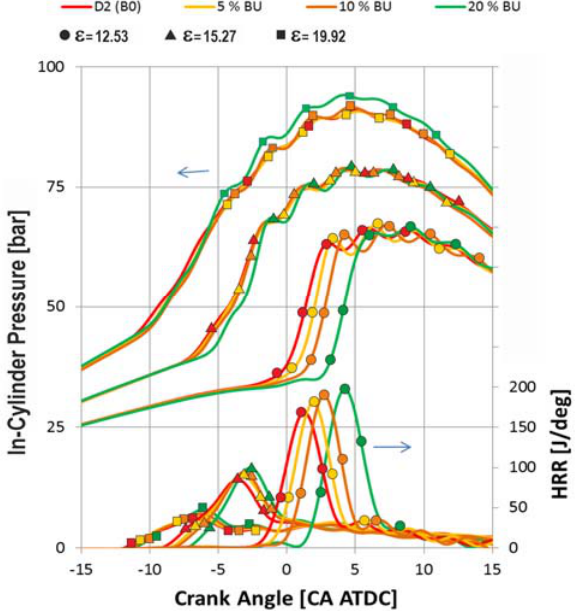
Figure 1. In-cylinder pressure and calculated HRR as a function of crankshaft angle with three different compression ratios ( σ Pi ± 3.59%, σ HRR ± 21.66%).